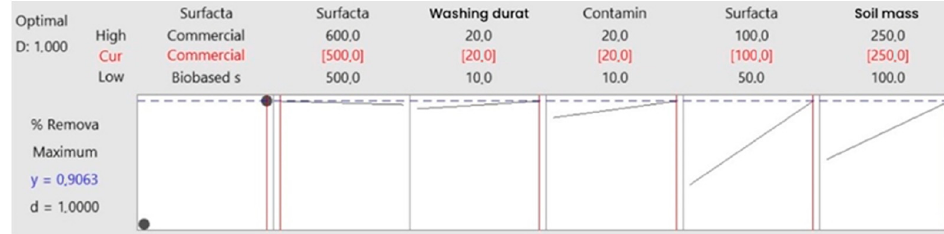
Figure 6. Multiple response prediction for optimization of oil removal (%) by the desirability function related to the 2 8-4 fractional factorial design.